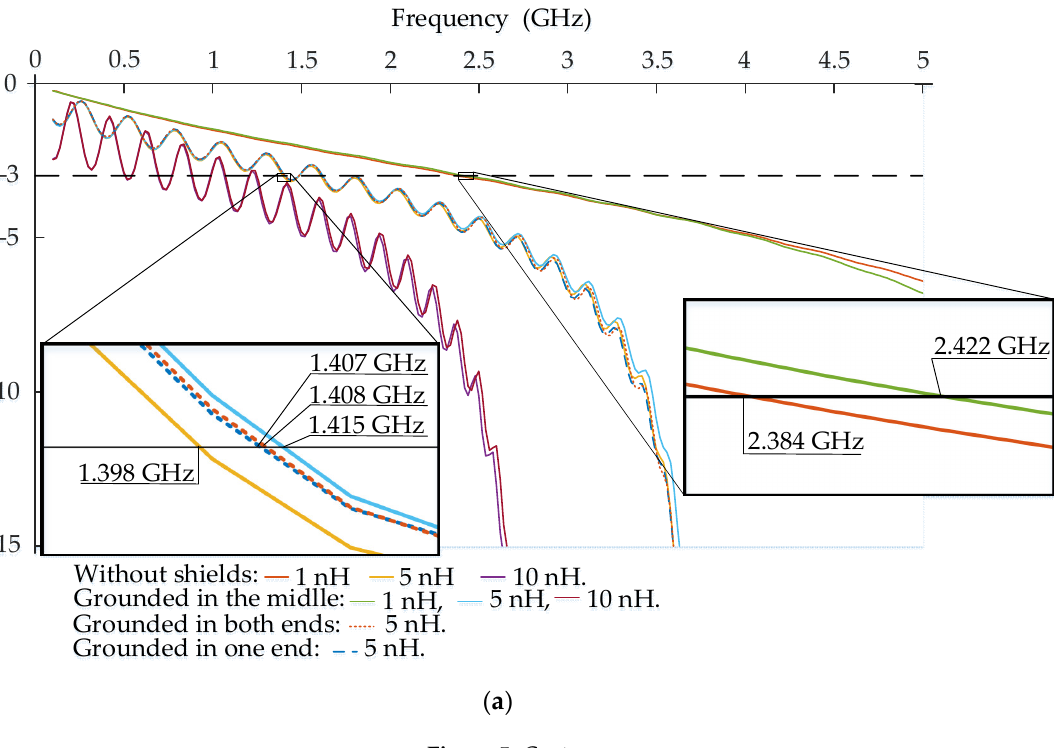
Figure 4. ( a ) A block diagram of an experimental measurement of the hybrid meander structure and ( b ) a general photograph of the experiment, where 1 is the hybrid meander structure with additional shields, 2 are SMA connections, 3 is a vector network analyzer, and 4 is a computer with the measurement software.